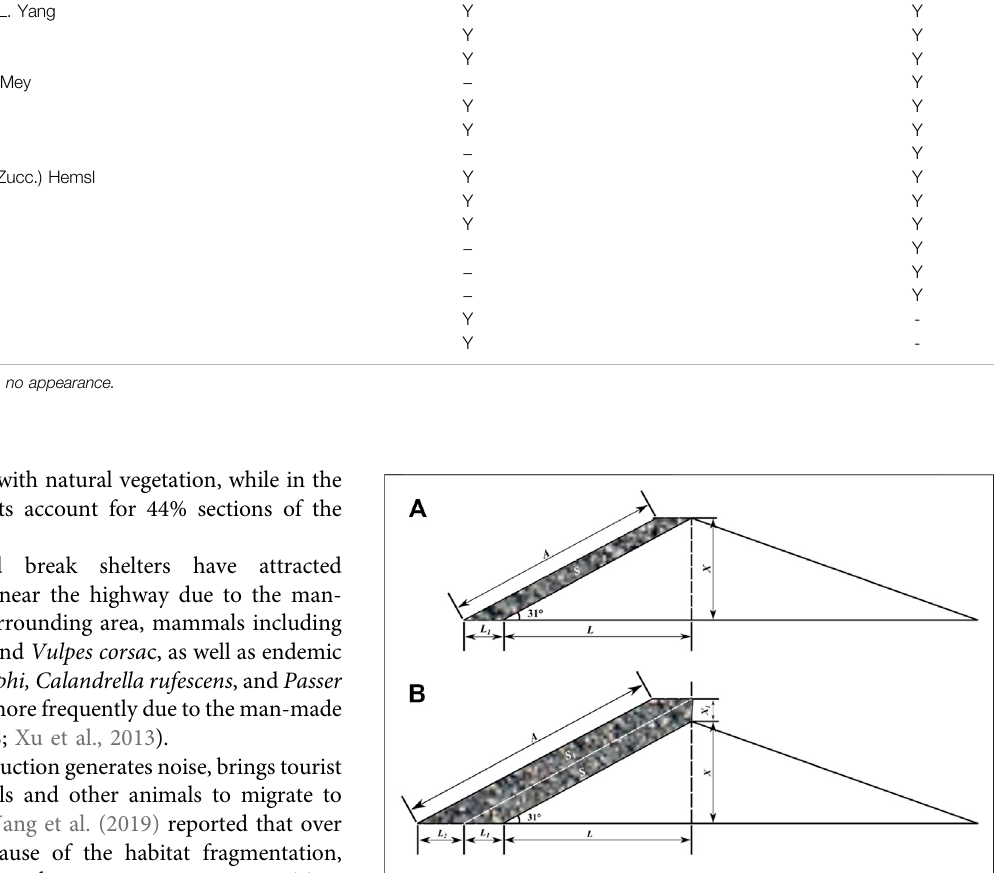
TABLE 1 | The herb species along the Taklamakan Desert Highway at different years. Herb Species 1992 and 1994 Hexinia polydichotoma (Ostenf.) H. L. Yang